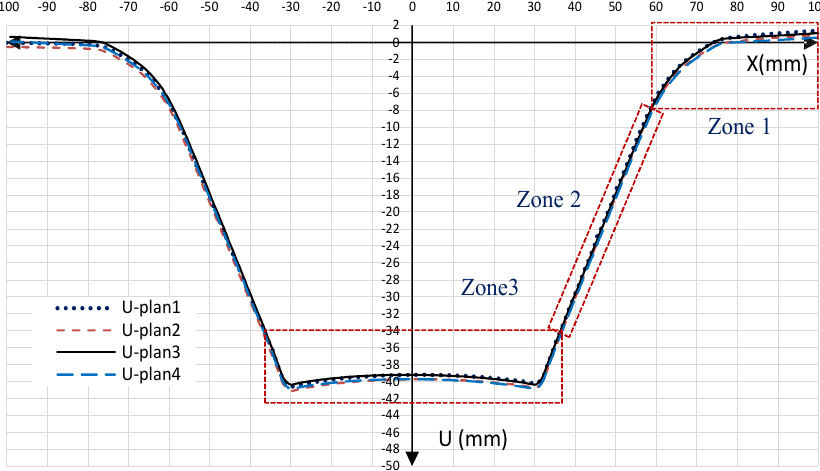
Figure 10. Experimental profiles shape according to the four cutting planes for h = 40 mm.